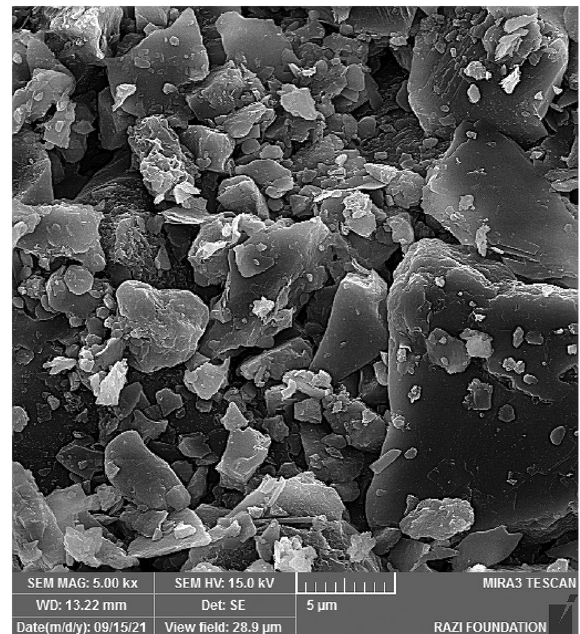
Fig. 3 SEM image of grains of native soil used in the CSG mixture